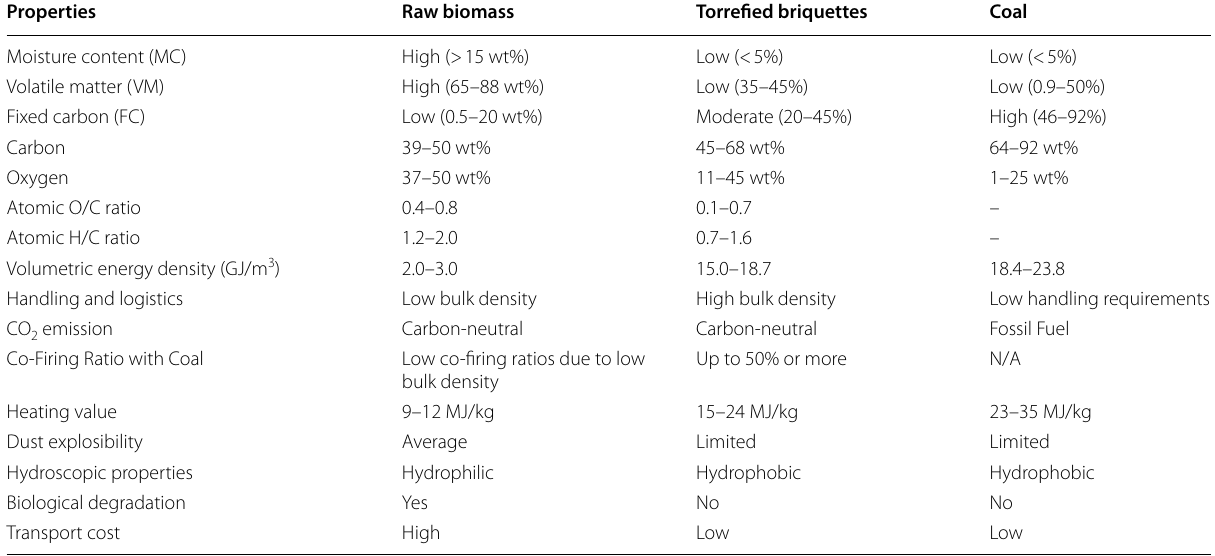
Nunes and Matias (2020), Chen et al. (2021)